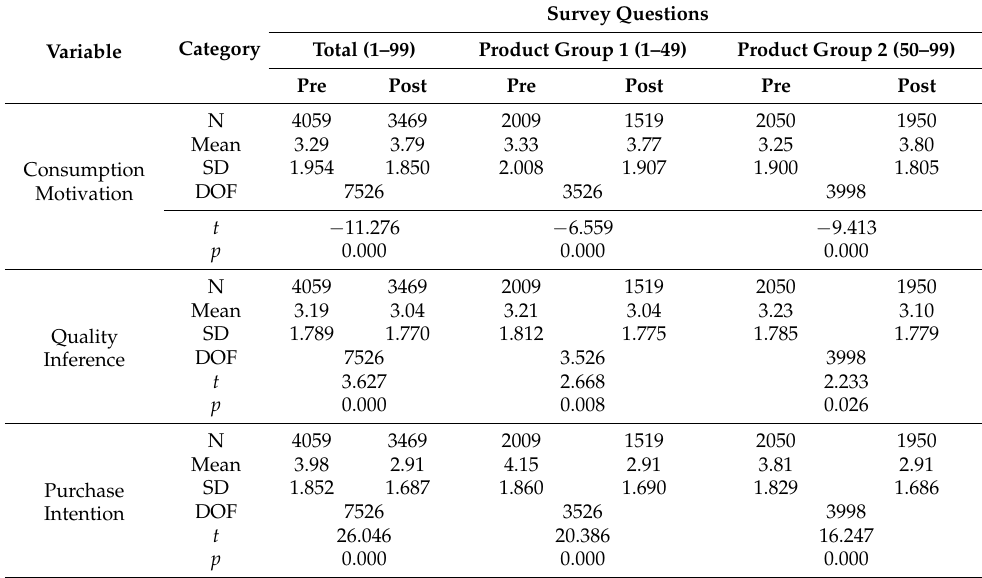
Table 8. General consumers: independent two-sample t -test results for posttest-only control group design.